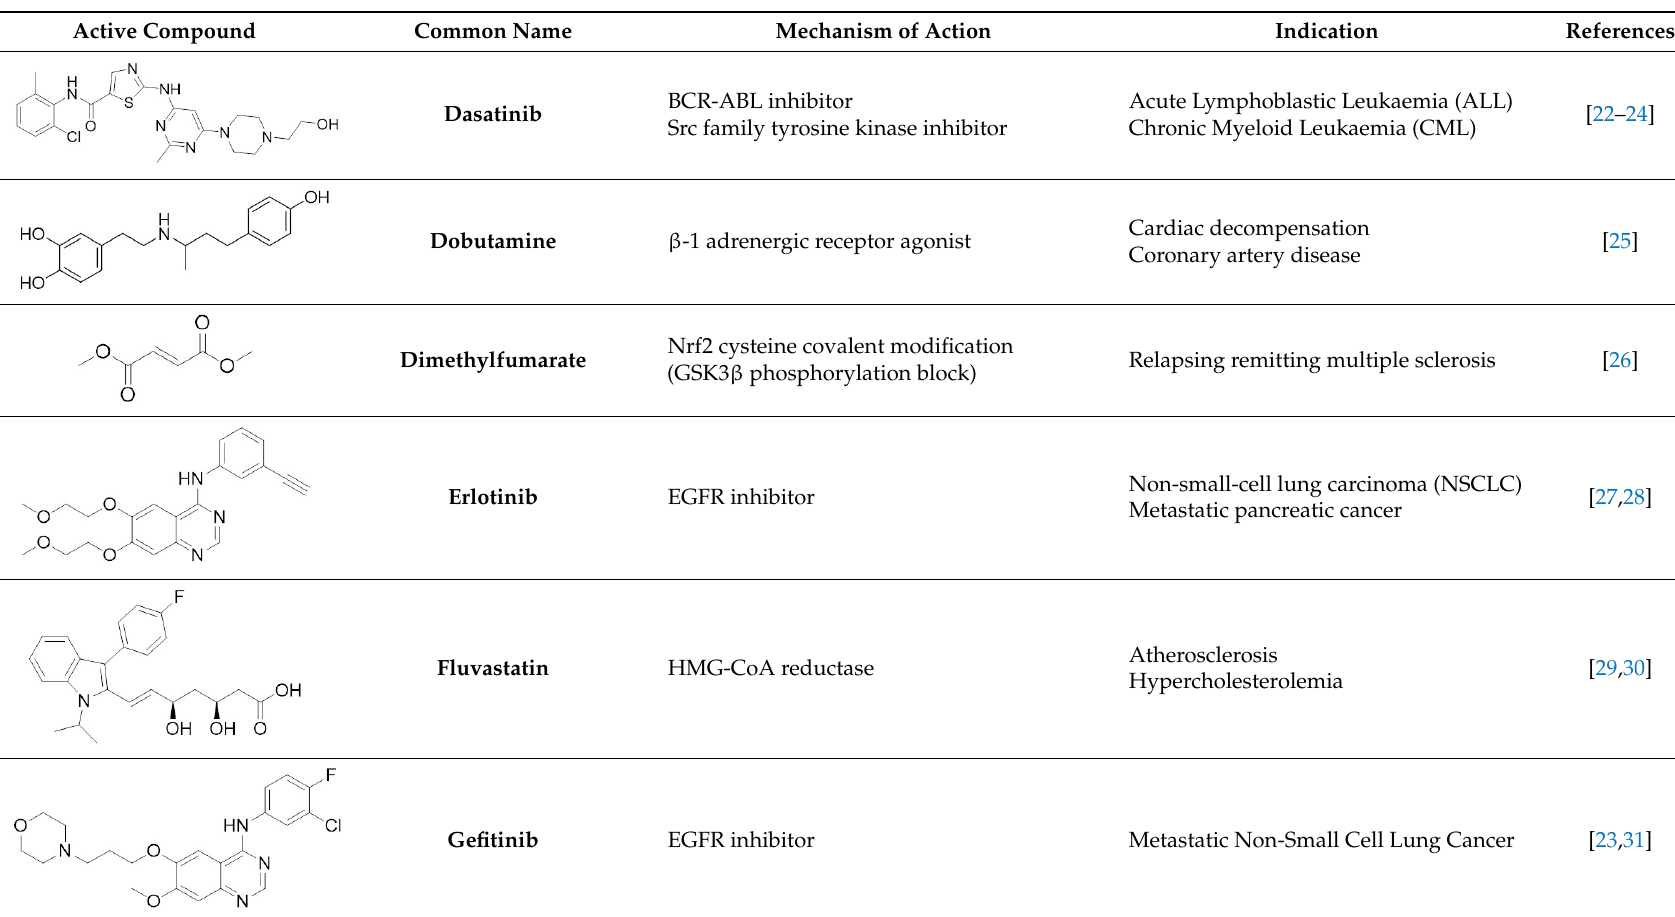
Table 1. Pharmaceutical agents targeting Hippo signaling through cross-talking pathways and their approved clinical indication.